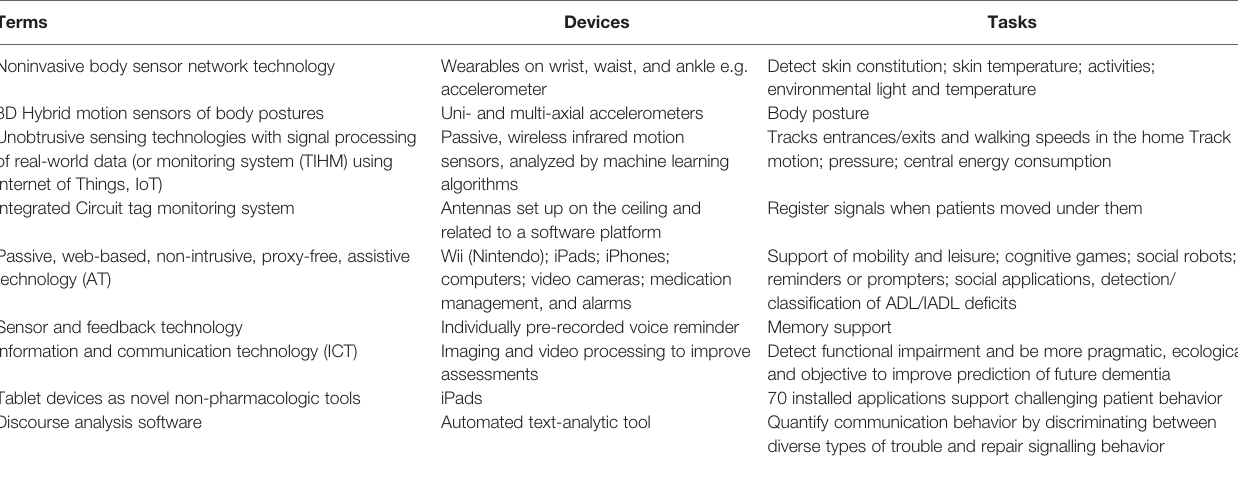
TABLE 6 | Terminology and content of different